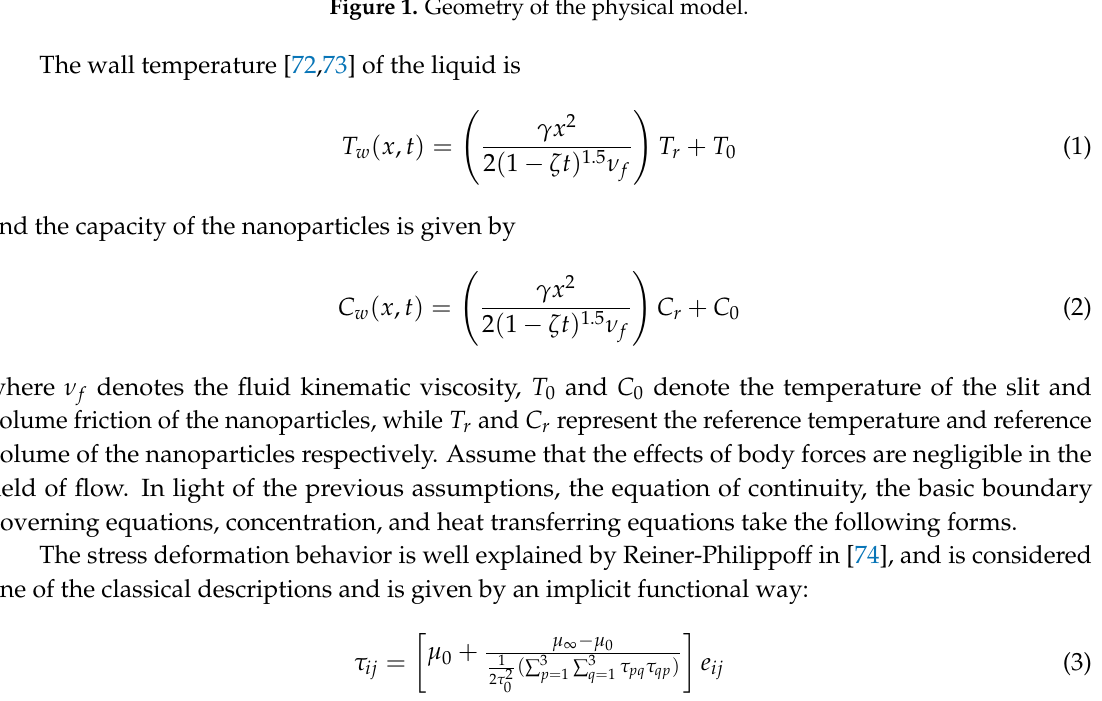
Figure 1. Geometry of the physical